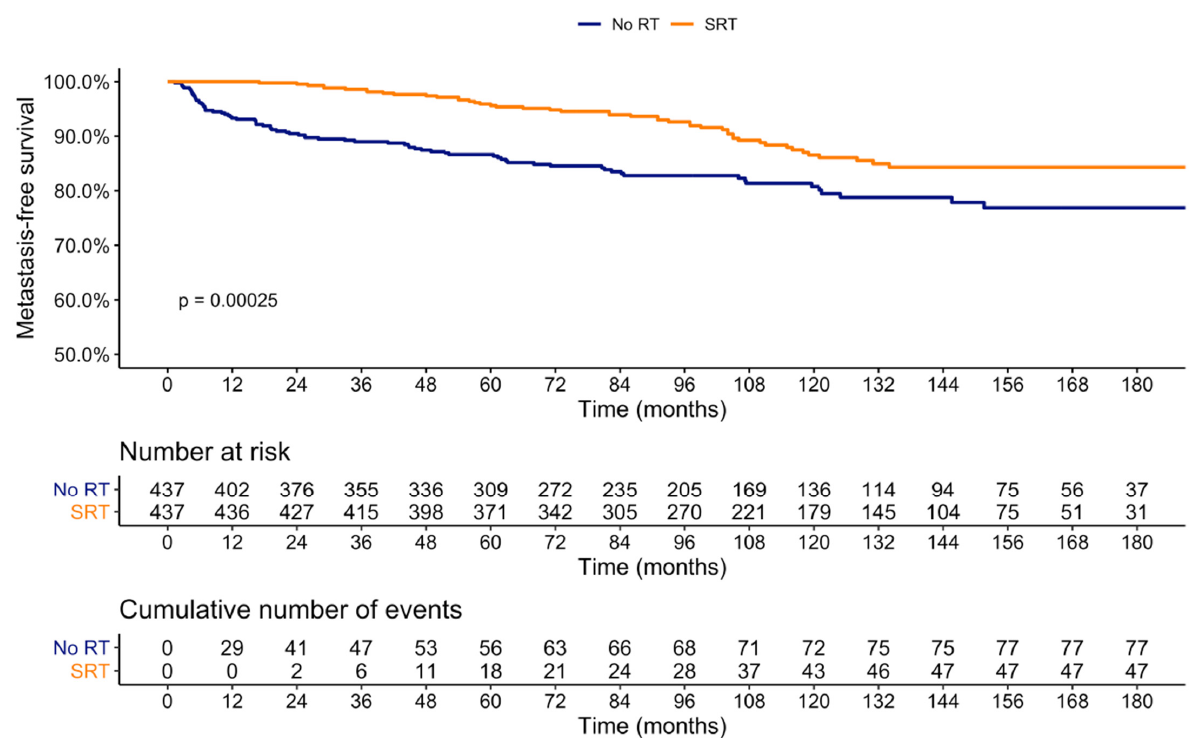
Figure 1. Kaplan–Meier plot depicting metastasis-free survival rates in prostate cancer patients treated with radical prostatectomy stratified according to observation vs. SRT for BCR, after 1:1 propensity score matching.